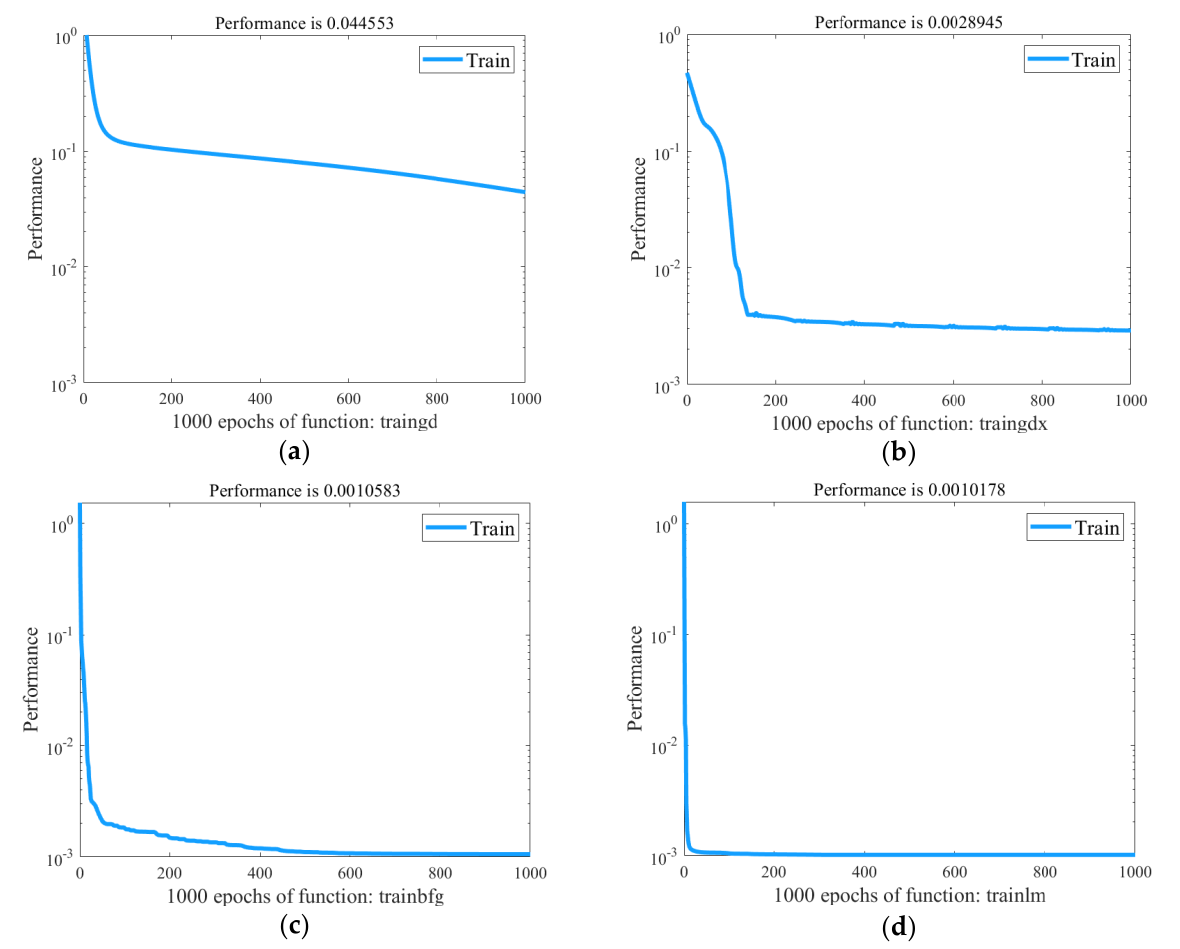
Figure 10. Performances of four training functions: ( a ) Performance of gradient descent backpropagation; ( b ) performance of gradient descent with momentum and adaptive learning rate backpropagation; ( c ) performance of BFGS quasi-Newton backpropagation; and ( d ) performance of Levenberg-Marquardt backpropagation.